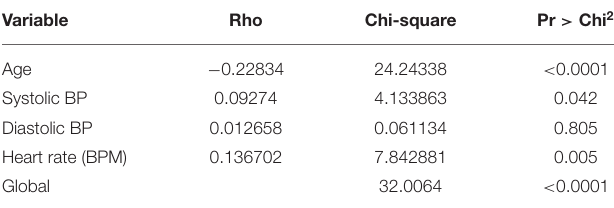
TABLE 10 | Proportionality test.